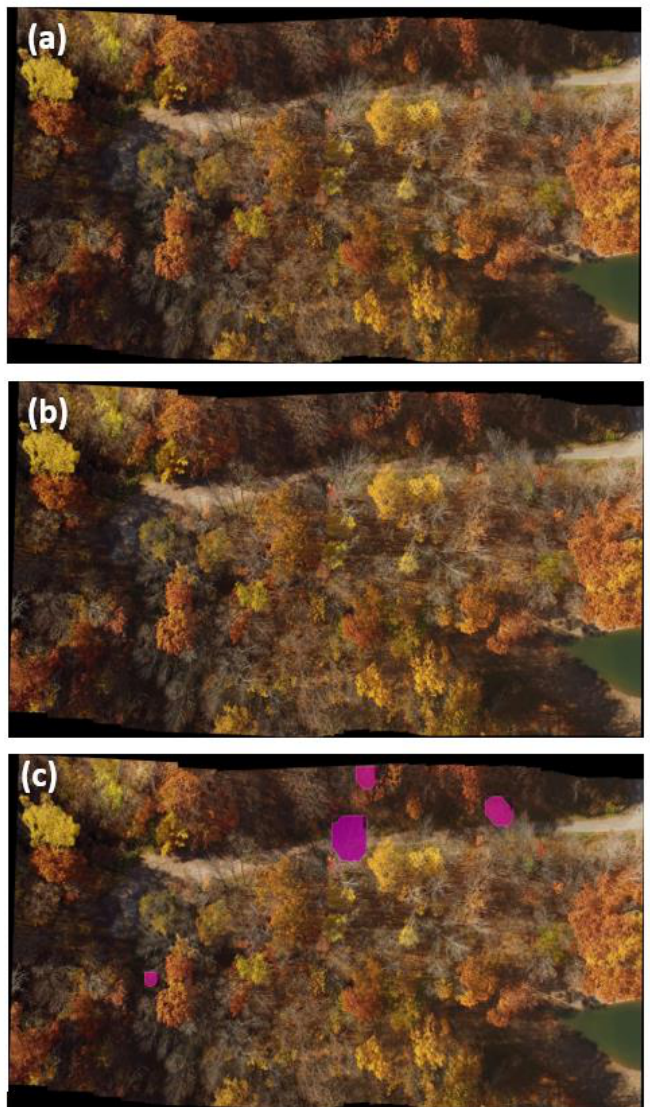
Figure 5. Prediction of Mask2former model on images taken in autumn; ( a ) is an input image, and ( b , c ) are the predictions with a threshold of 0.5 and 0.1, respectively.